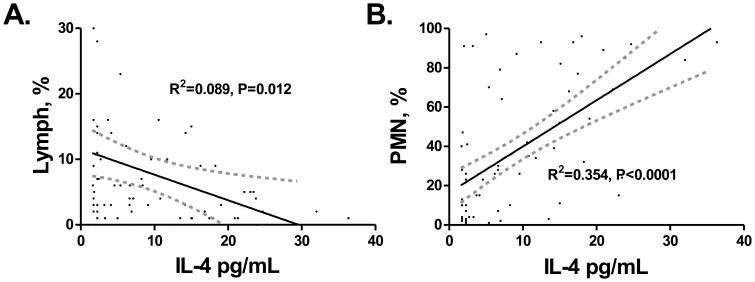
Correlation of BAL supernatant IL-4 with BAL cell differential.A. Lymphocyte %. B. Polymorphonuclear Neutrophils %. Linear regressions with 95% confidence intervals.